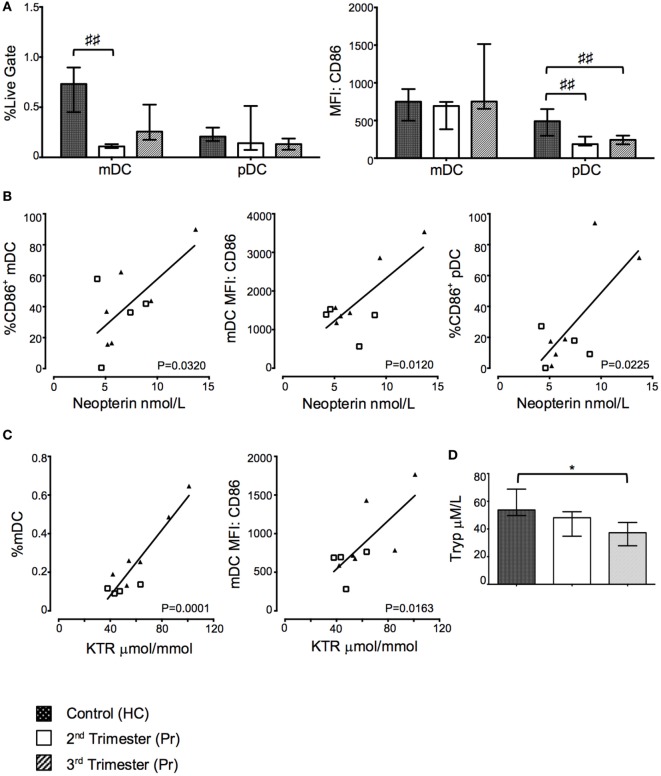
Proportions of myeloid dendritic cell (mDC) and costimulatory CD86 expression on plasmacytoid DC (pDC) were reduced in pregnancy but positively correlated with indoleamine 2,3-dioxygenase (IDO) activity. (A) Proportions of mDC and pDC and their respective expression of CD86 in pregnancy and compared to controls. (B) Correlation between CD86 expression on DCs and plasma neopterin concentration. (C) Correlation between mDC proportions, CD86 expression, and plasma kynurenine/tryptophan ratio (KTR). (D) Plasma tryptophan, kyurenine concentration, and KTR (μmol/mmol) during pregnancy. Columns indicate median and error bars interquartile range. ♯♯p < 0.01 (Kruskal–Wallis one way analysis of variance and Dunn’s test for multiple comparisons), *p < 0.05 (Mann–Whitney U). Abbreviations: HC, healthy control; MFI, mean florescence intensity; Pr, pregnant.